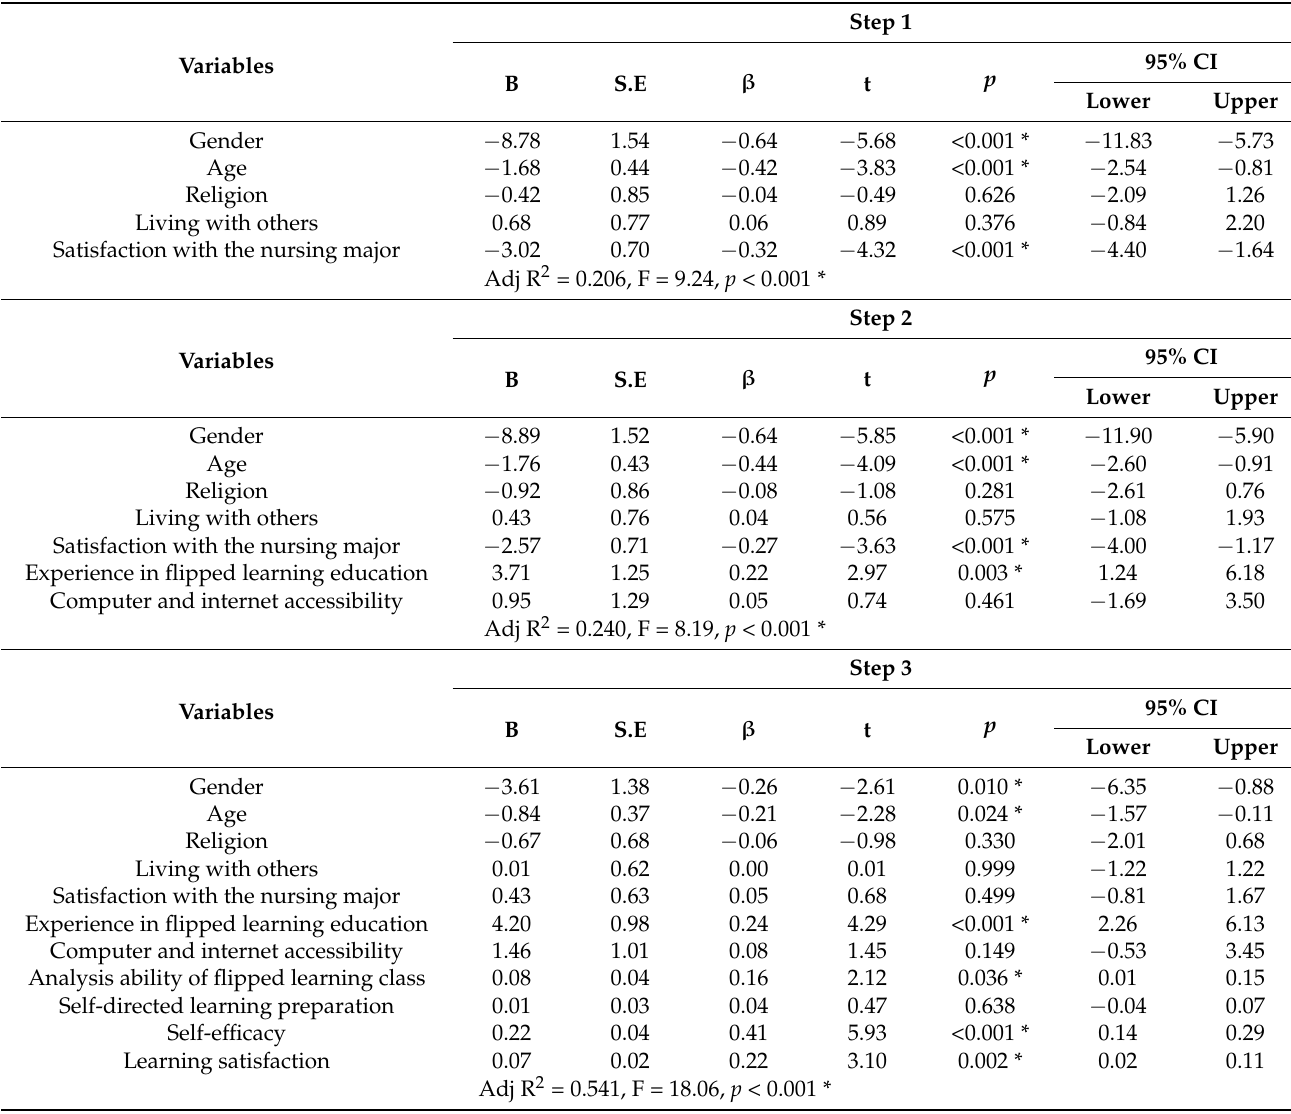
Table 5. Factors affecting academic